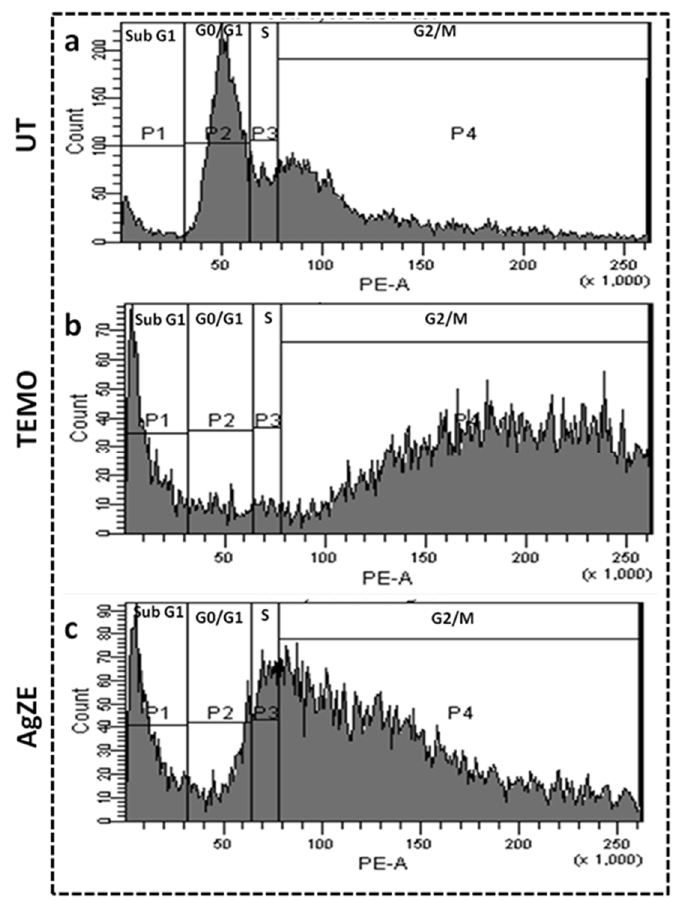
Figure 4. Cell cycle analysis of U-87 cells using flow cytometry, where groups are: ( a ) untreated, ( b ) temozolomide: TEMO (positive control), and ( c ) AgZE (IC50: 4.1 µL) treated at 24 h. AgZE exhibits sub G1 and G2/M phase cell cycle arrest in comparison to untreated cells showing apoptosis induced cell killing